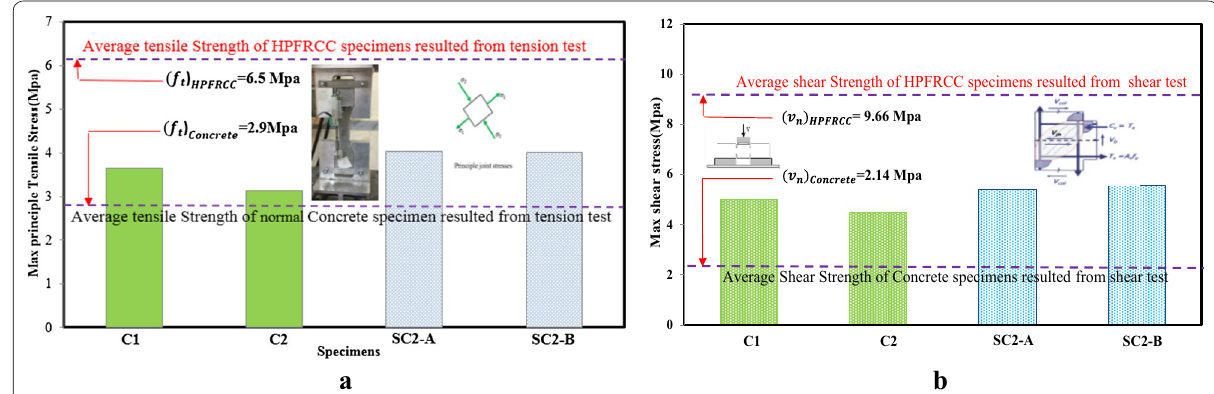
Fig. 28 a Comparison of maximum principal tensile stress induced in joint with tensile strength of specimens; b comparison of maximum shear stress induced in joint with shear strength of